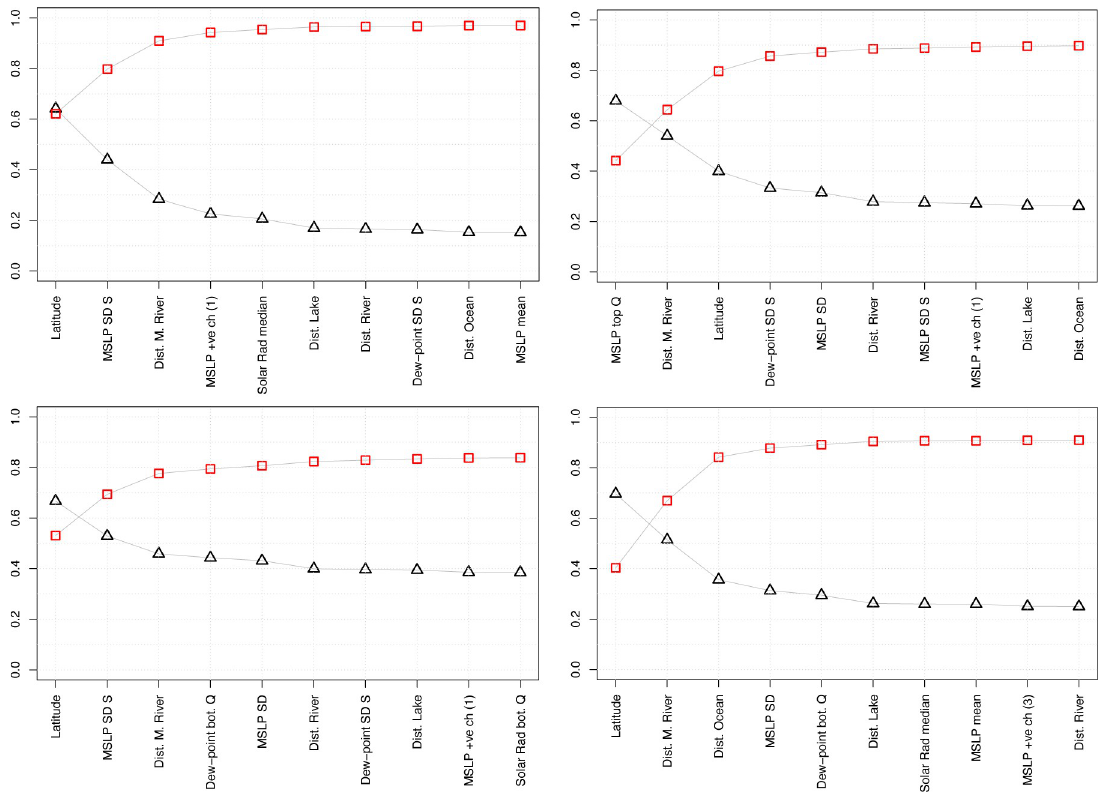
Fig 3. Summary statistics of GCP-PC prediction. Statistics of log 10 GCP-PC prediction using 5-fold cross validation, adding one predictor at the time (forward step-wise approach) in the order given and up to 10 predictors. For instance, in the top left panel ‘MSLP SD S’ means that ‘MSLP SD S’ and ‘Latitude’ are used together (cf. also Table 4). Top left: all grid points. Top right: top tercile of GCP-PC. Bottom left: middle tercile of GCP-PC. Bottom right: bottom tercile of GCP-PC. Metrics used are: linear correlation (red squares) and normalised Mean Absolute Error (nMAE, black triangles). nMAE is equal to 0.56 for all grid points, 0.17 for the top and mid terciles, 0.26 for the bottom tercile.